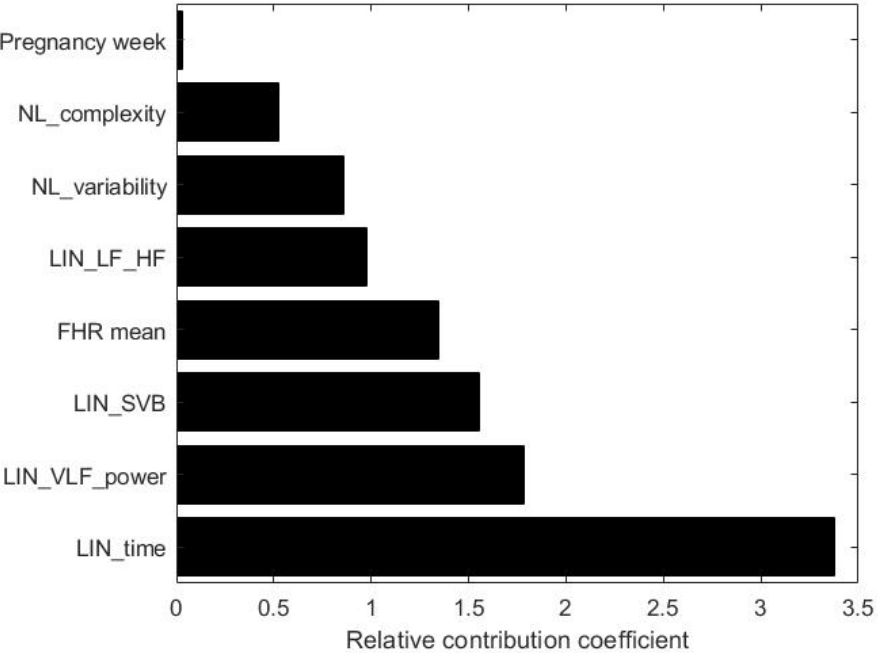
Figure 8. Plot of the ANN feature importance.